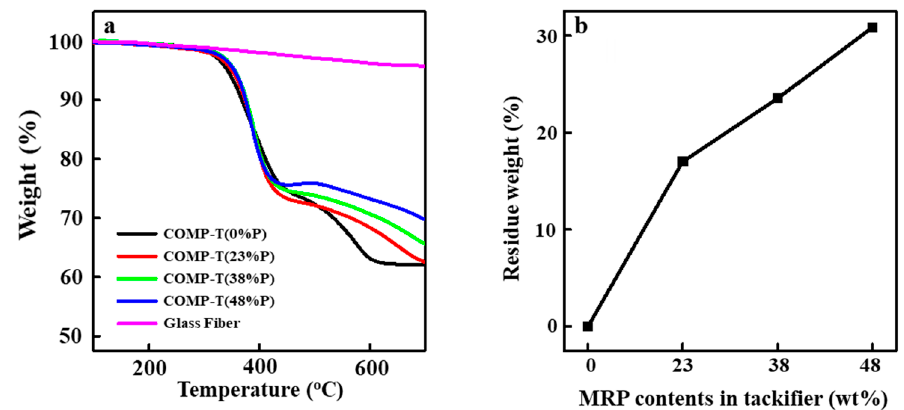
Figure 4. ( a ) Thermogravimetric registrations with a heating rate of 10 °C min − 1 under an air atmosphere and ( b ) calculated residues (600 °C) of the organic material, including the resin, tackifier, and fiber sizing coating, for the RTM epoxy composites preformed by ET3228 tackifiers with MRP content in the range of 0 to 48 wt.%.